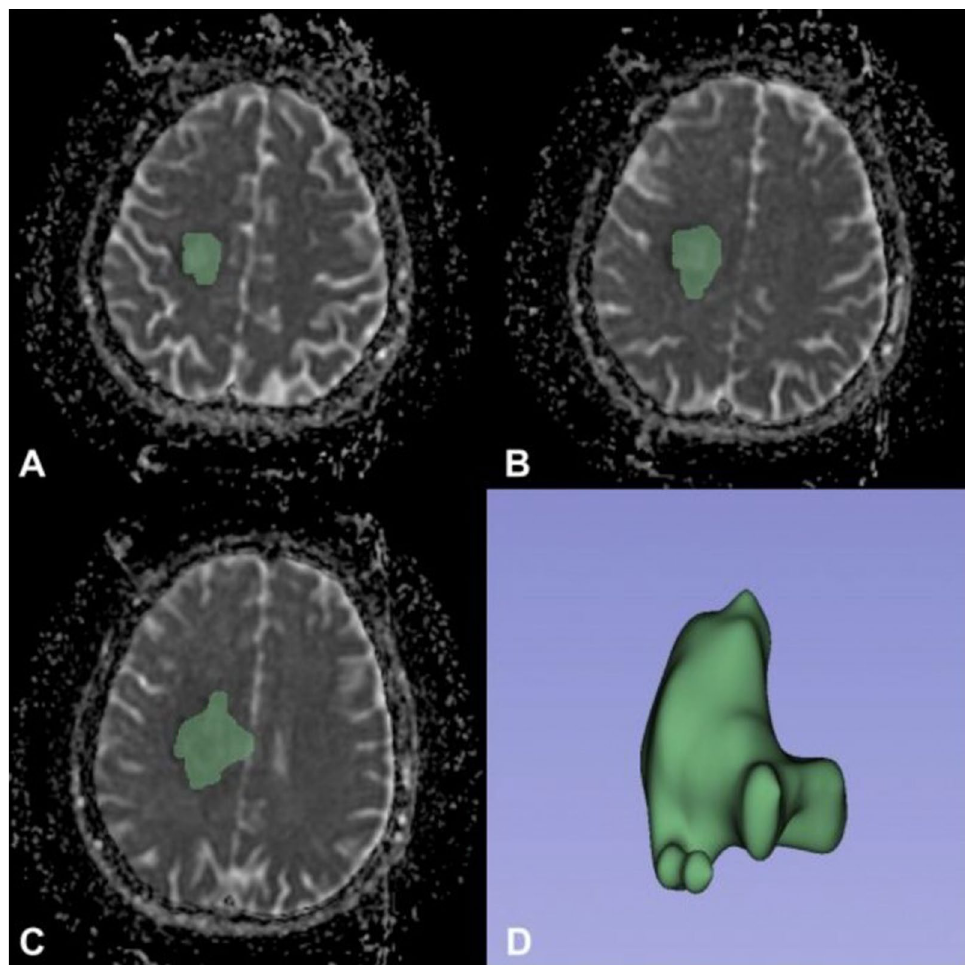
Fig. 4 A , B , and C : Axial ADC sections show segmentation of IDH-mutant type tumour from the level of convexity (green). D : The three-dimensional model of the tumour created as a result of segmentation is